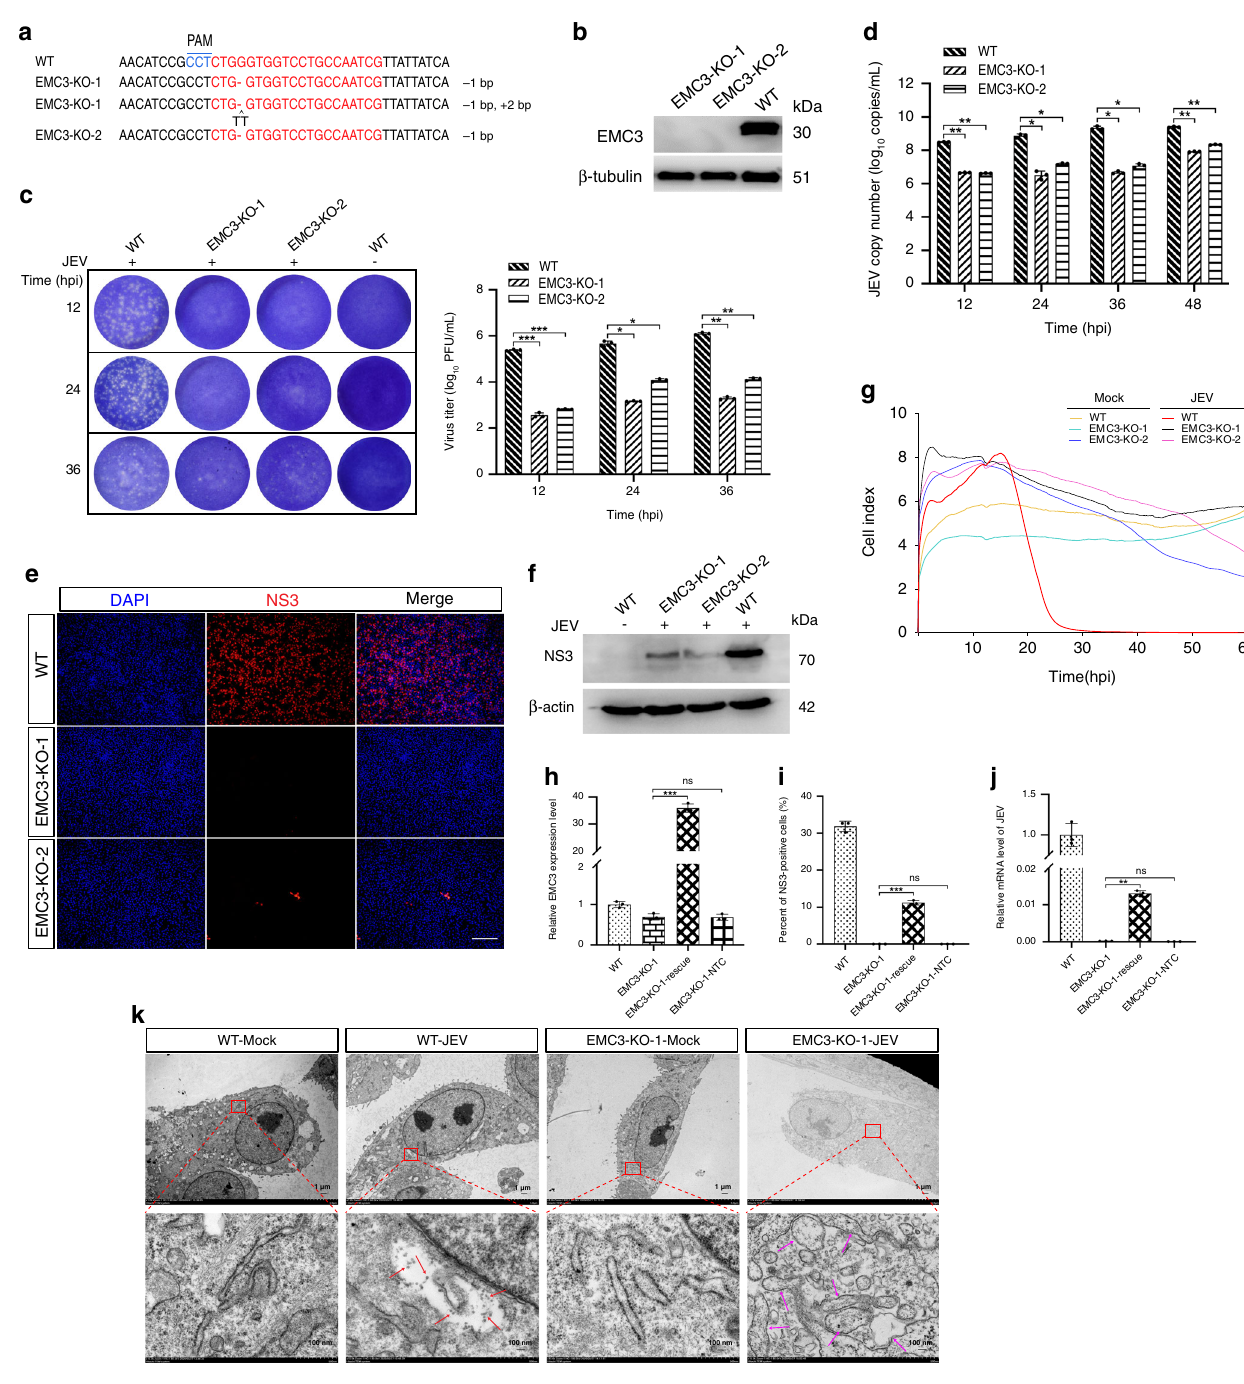
JEV-induced death at an MOI of 1 was evaluated. The result from cultures grown using a Real-Time Cell Analyzer assay veri fi ed that EMC3-de fi cient cells were able to completely resist JEV- induced PK-15 cell death (Fig. 5g). Subsequently, we found that rescue assays for ectopic expression of EMC3 in EMC3 - de fi cient cells resulted in partial recovery of JEV replication (Fig. 5h – j, Supplementary Fig. 16a). As shown in Fig. 5j, the proportion of NS3-positive cells was signi fi cantly increased during restoration of EMC3 expression in EMC3-de fi cient cells. Further analysis revealed that knockdown of EMC3 signi fi cantly inhibited JEV replication in both PK-15 and ST cells (Supplementary Fig. 17,